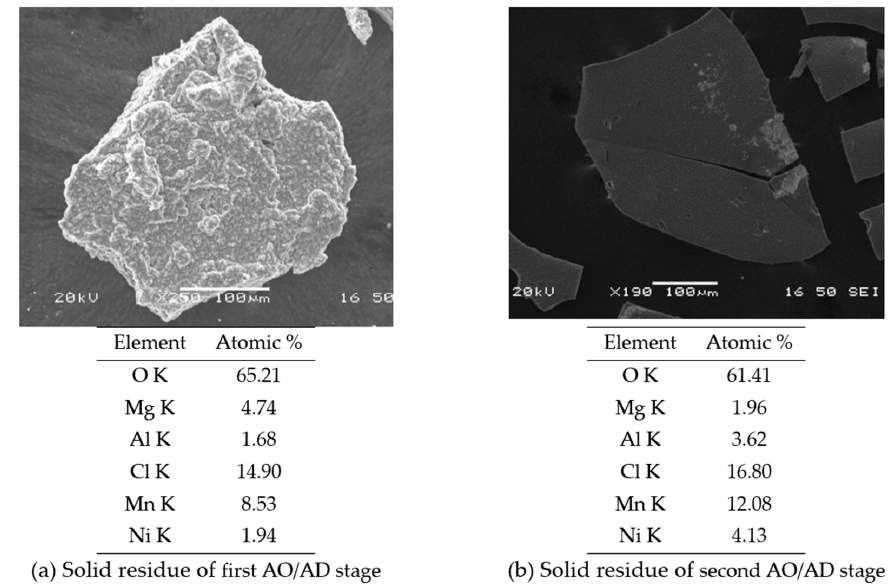
Figure 11. SEM and EDS analyses of MnO 2 solid residue obtained from the first and second AO/AD stages.